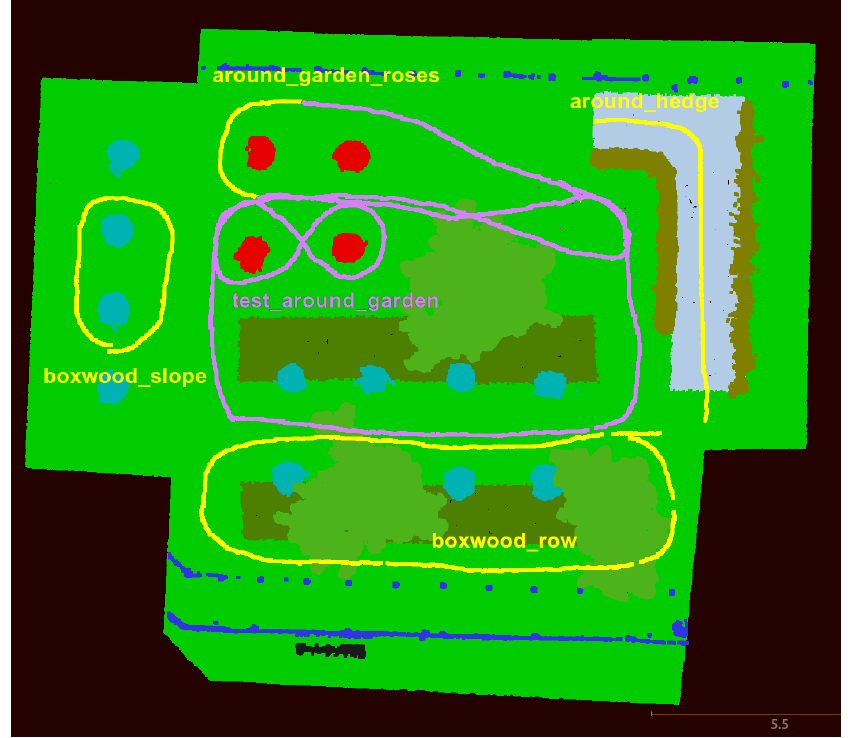
Figure A1. Trajectories of the captured scenarios for the 3D Reconstruction Meets Semantics (3DRMS) Challenge 2017 dataset: training (yellow) and test (purple)